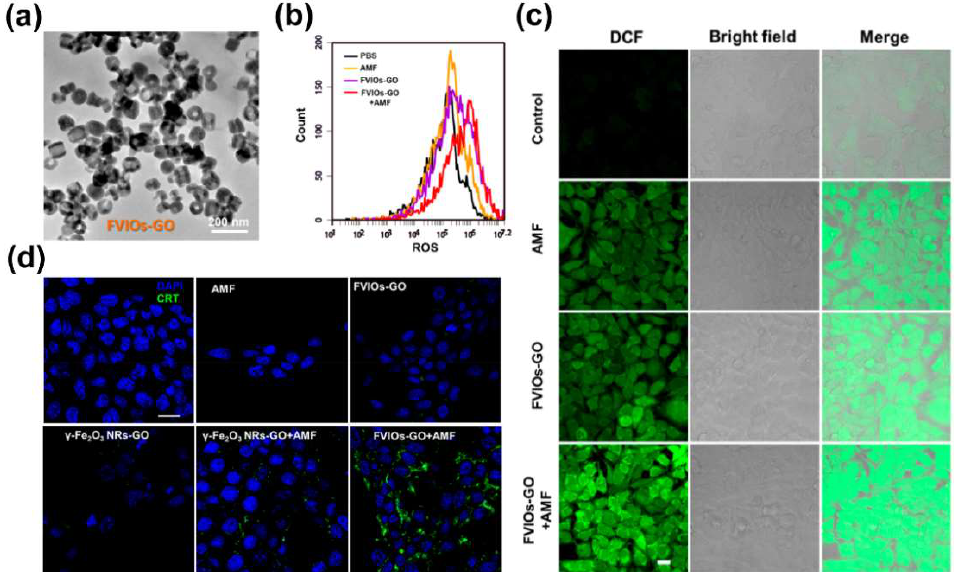
Figure 4. ( a ) TEM image of FVIOs–GO. ( b ) ROS generation of 4T1 breast cancer cells after treatment in a flow cytometry assay. ( c ) Confocal laser scanning microscope (CLSM) images of 4T1 cells treated with complete media (control), AMF, FVIOs–GO only, and FVIOs–GO–containing media under AMF. Generation of ROS was monitored using DCFH–DA (green). Scale bars for all images are 20 μm. ( d ) Confocal images showing the CRT exposure on 4T1 tumor cells in vitro after treatment with γ–Fe 2 O 3 nanorings+AMF or FVIOs–GO–mediated magnetothermodynamic (MTD) therapy. Scale bars for all images are 20 μm. Reprint with permission from [57]. Copyright 2020 American Chemical Society.